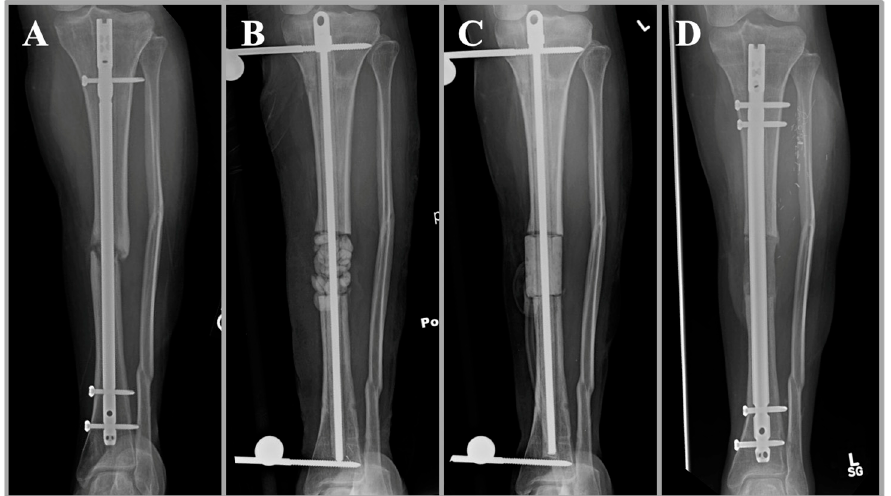
Figure 2. A PMMA-coated intramedullary nail can be fabricated using a chest tube or a threaded rod or guidewire. After mixing, the cement is injected into the chest tube and the rod is inserted. The tubing is then removed after the PMMA has hardened using a scalpel.